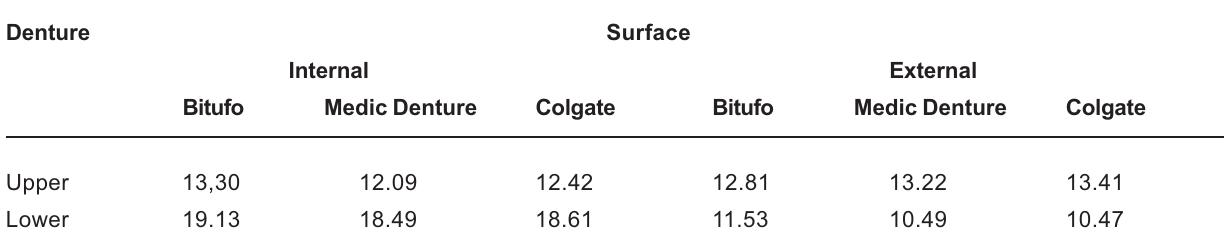
TABLE 1- Biofilm percent means from internal and external surfaces of upper and lower dentures